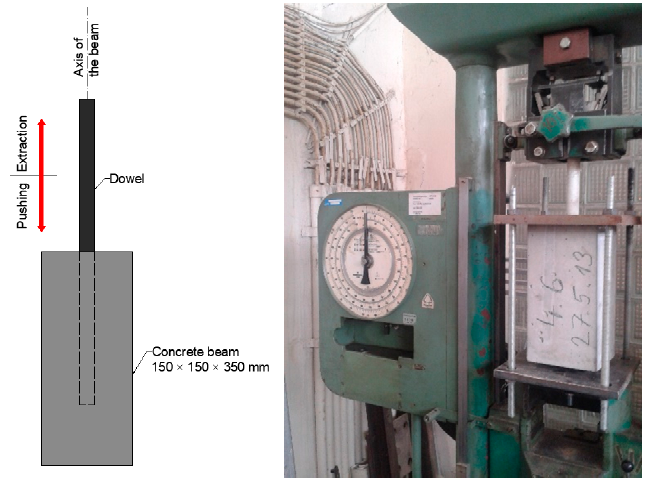
Figure 5. Longitudinal displacement—test of extracting/pushing of dowels into the concrete beam.